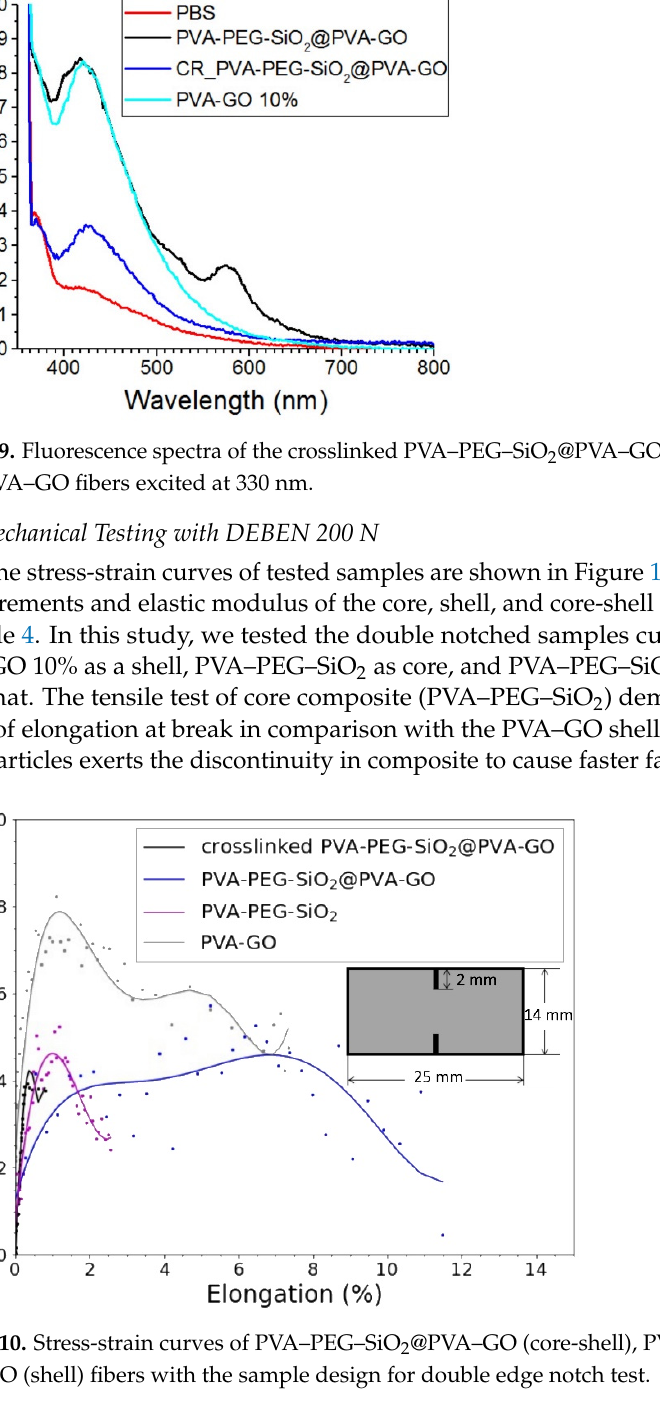
Table 4. The tensile properties of PVA–PEG–SiO 2 @PVA–GO, PVA–PEG–SiO 2 (core), and PVA–GO (shell) fibers.